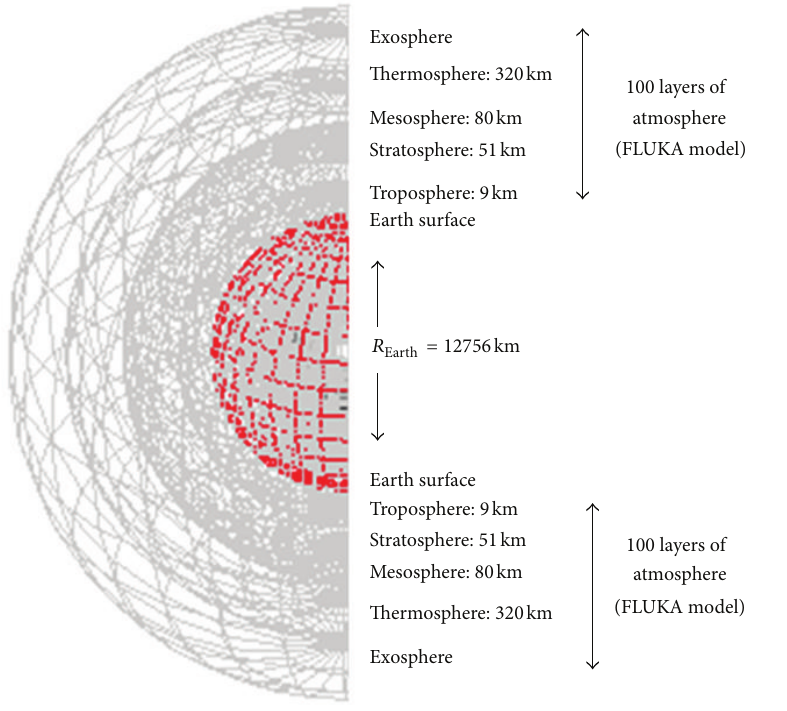
Figure 1: 100 layered FLUKA atmosphere model.